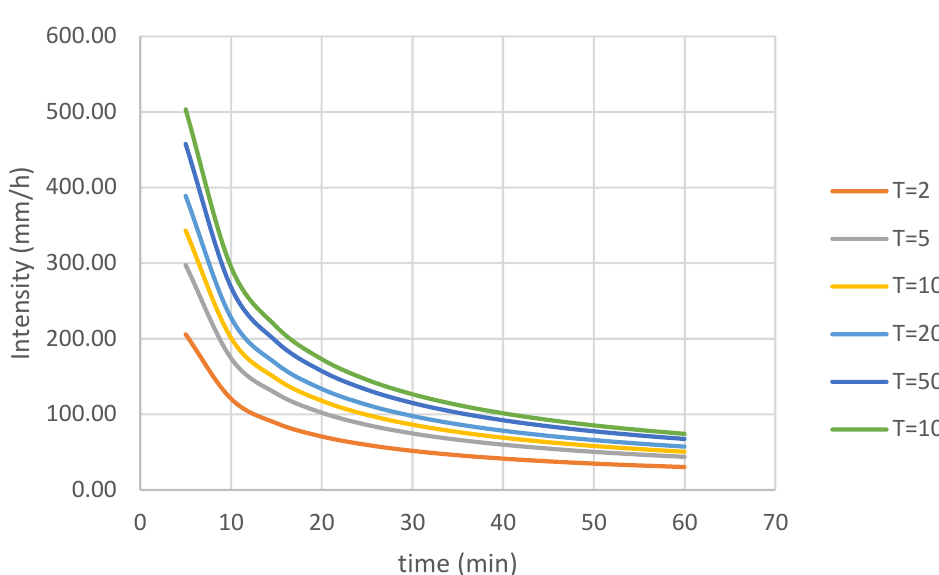
Figure 5. Balloon Network.